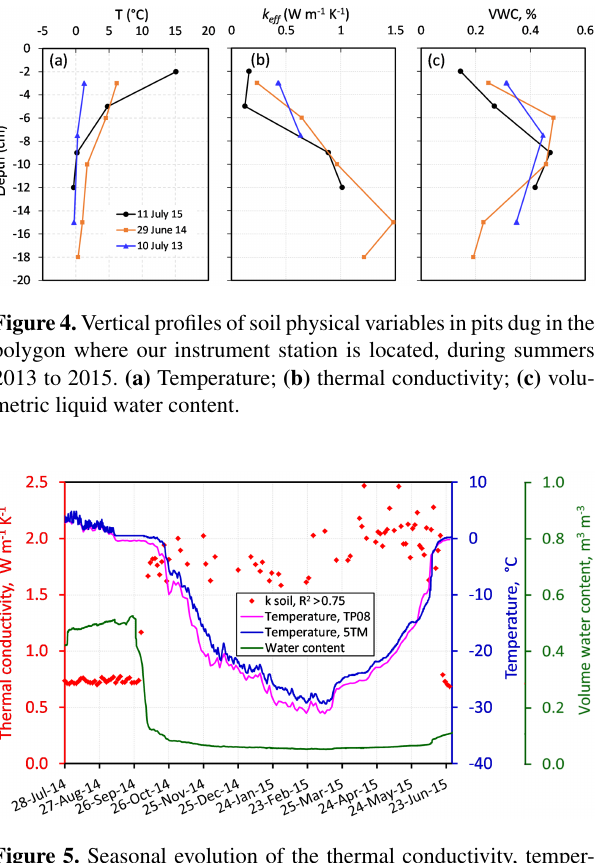
Figure 5. Seasonal evolution of the thermal conductivity, temper- ature and volume water content of the soil at 10cm depth for the 2014–2015 season. The 5TM probe which measures both tempera- ture and water content hourly is about 2m from the TP08 NP, which measures thermal conductivity and temperature every 2